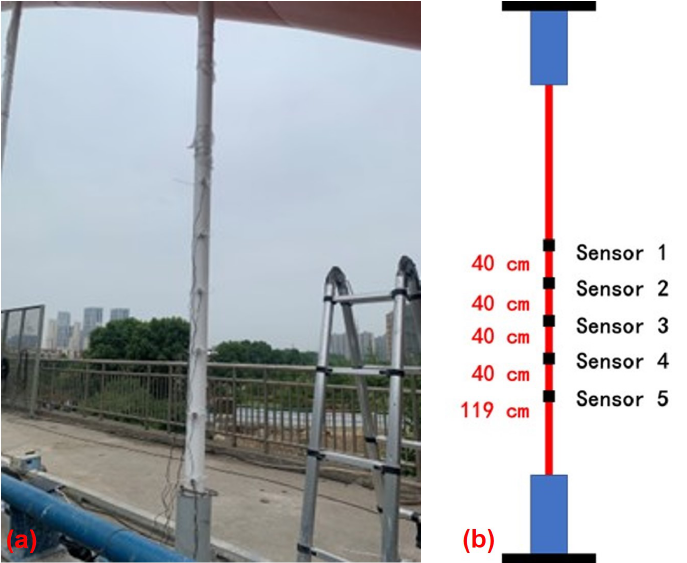
Figure 6. Multiple sensor arrangements of the experiments. ( a ) Sensor layout in experimental field; ( b ) sensors arrangement